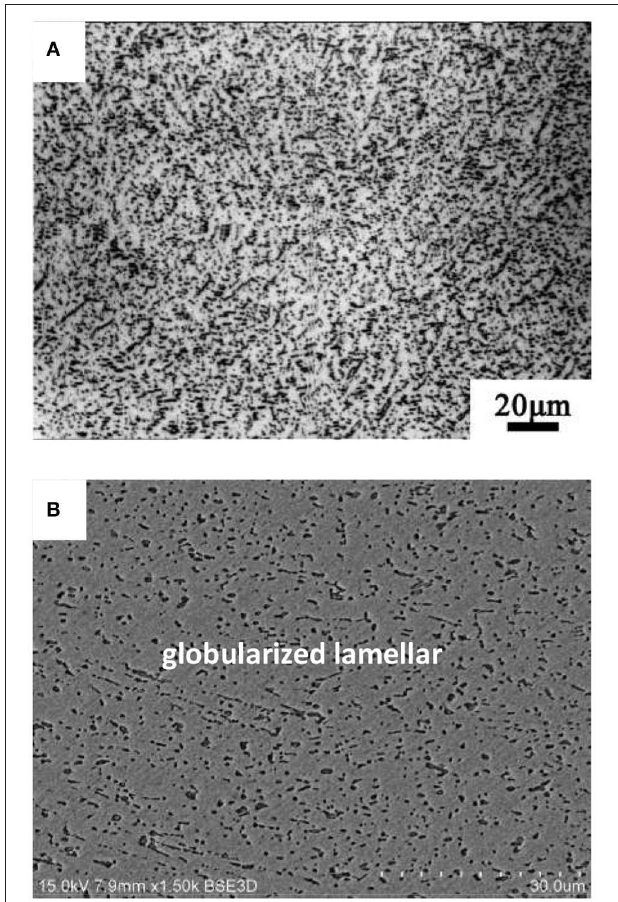
FIGURE 8 | The microstructure of the Ti-25.5Al-13.5Nb-2.8Mo-1.8Fe alloys deformed at 950 ◦ C/0.001 s − 1 : (A) OM image; (B) SEM